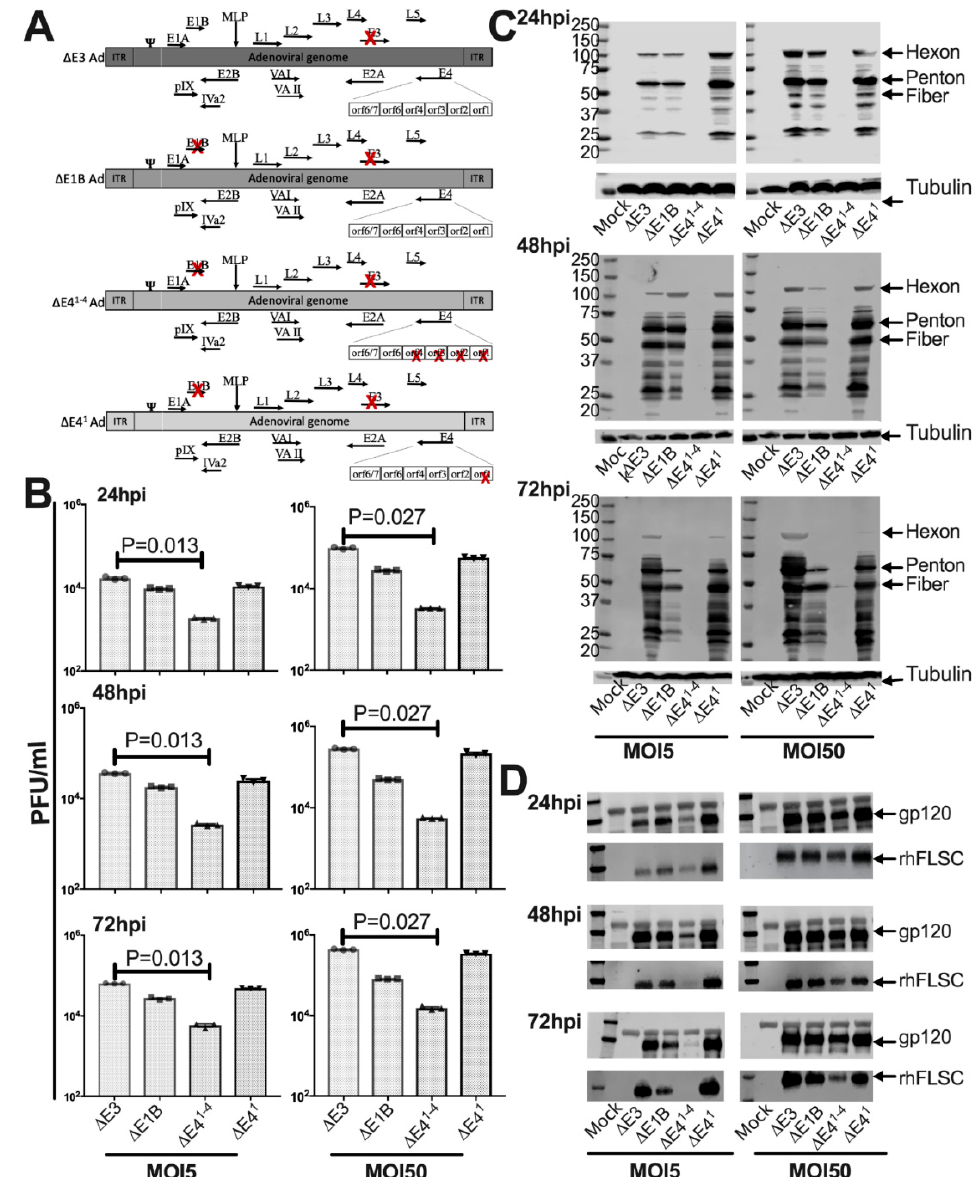
Figure 1. Characterization of Ad5hr HIV-vaccine candidates in infected A549 cells. ( A ) A schematic of the Ads used in this study. A red X marks the deleted genes in each of the Ads. ( B – D ) A549 cells were infected at an MOI of 5 or 50 for 24, 48 and 72 h. ( B ) Viral progeny were assessed by plaque assay using HEK-293 cells. Mean values ± SEM were plotted. ( C ) Ad late proteins (hexon, penton and fiber indicated) with tubulin, and ( D ) gp120 and rhFLSC were assessed by western blot. All experiments were repeated at least 3 times. p values were obtained using the Mann–Whitney unpaired t-test.